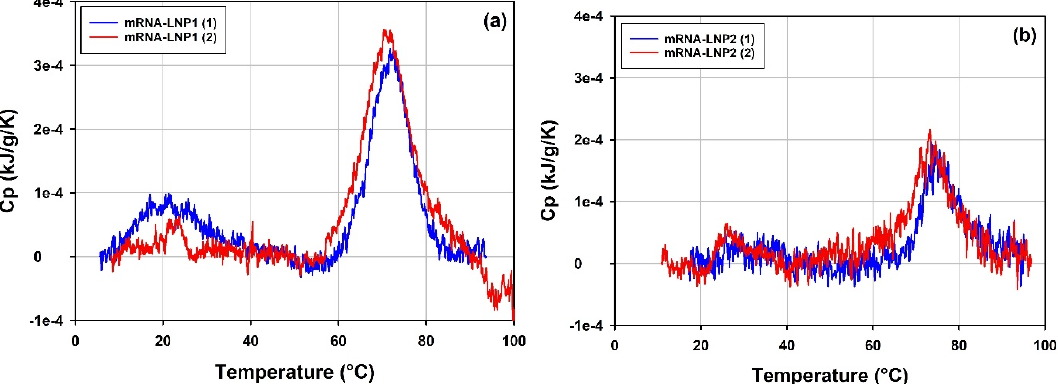
Figure 14. Overlays of the thermograms obtained for ( a ) mRNA-LNP1 and ( b ) mRNA-LNP2 batch 1 samples. DSC data corrected for the instrumental blank and the baseline and normalized for the total lipid concentration.